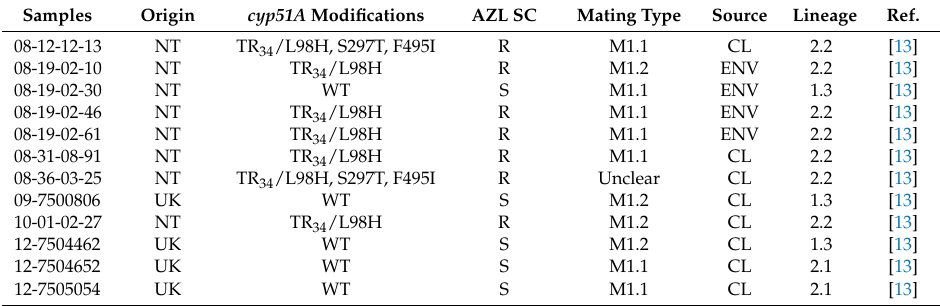
Table 2. Aspergillus fumigatus genomes from public data bases included in this study. The assigned lineage is based on the phylogenetic